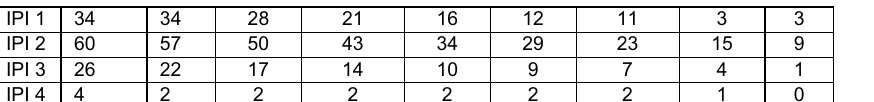
Figure 4. Overall survival (OS) and progression free survival (PFS) according to IPI score. OS ( A ) at 5 year was 100% for IPI 1, 96% for IPI 2, 84% for IPI 3 and 50% for IPI 4. PFS ( B ) at 5 year was 100% for IPI 1, 965% for IPI 2, 80% for IPI 3 and 50% for IPI